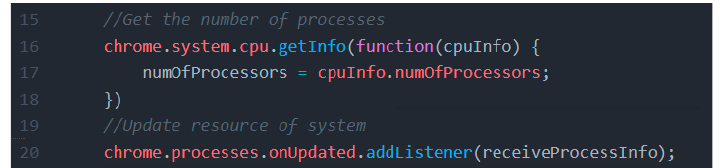
Figure 9. Obtain system information through Chrome extensions APIs.